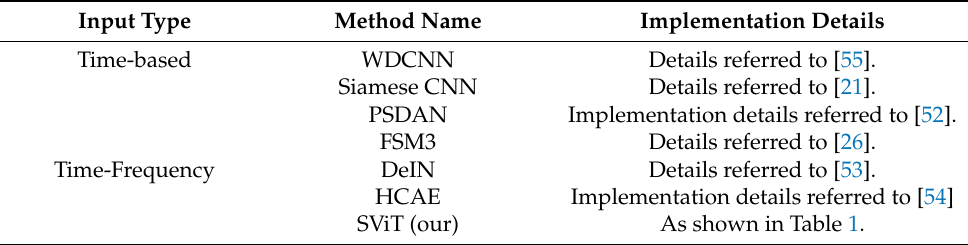
Table 3. The comparison